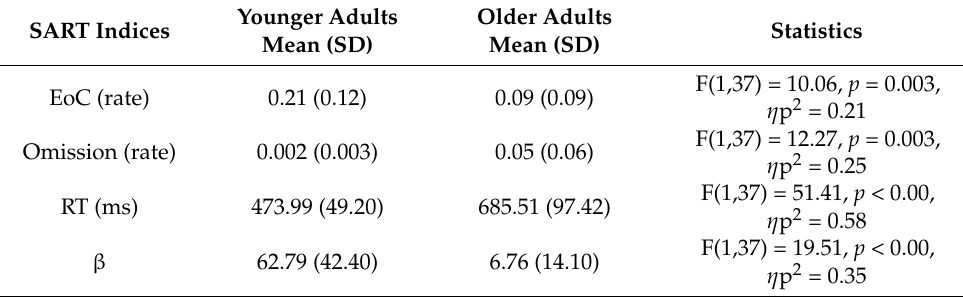
Table 2. The age effect on SART